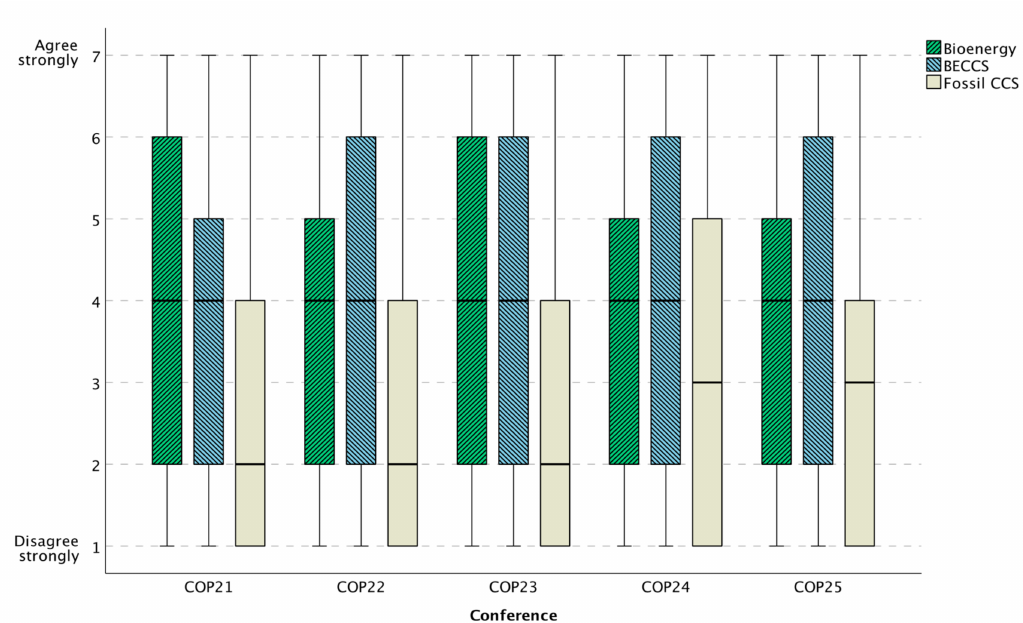
Figure 2. Survey data from general attendees at the COPs indicates an overall more positive response to BECCS than fossil CCS, and to BECCS than bioenergy without